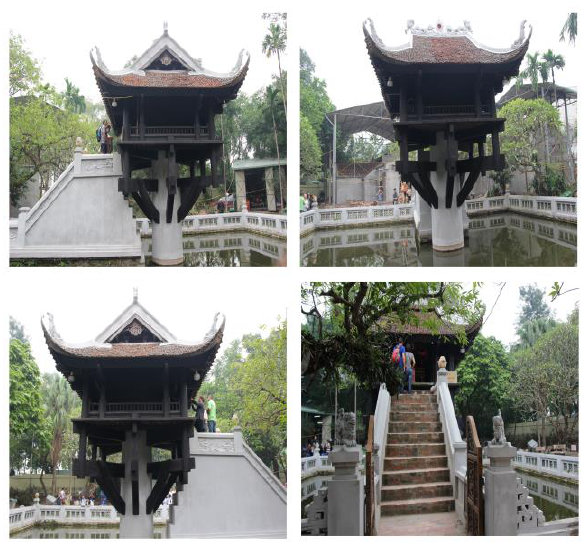
Figure 2. Figure placement and